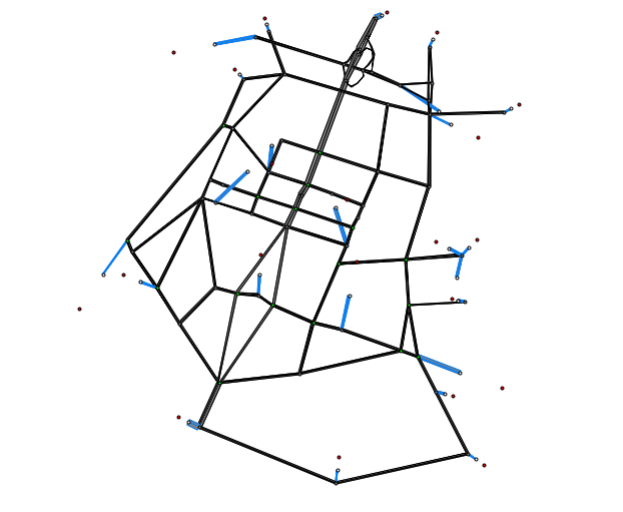
Figure 6. The “Eur”